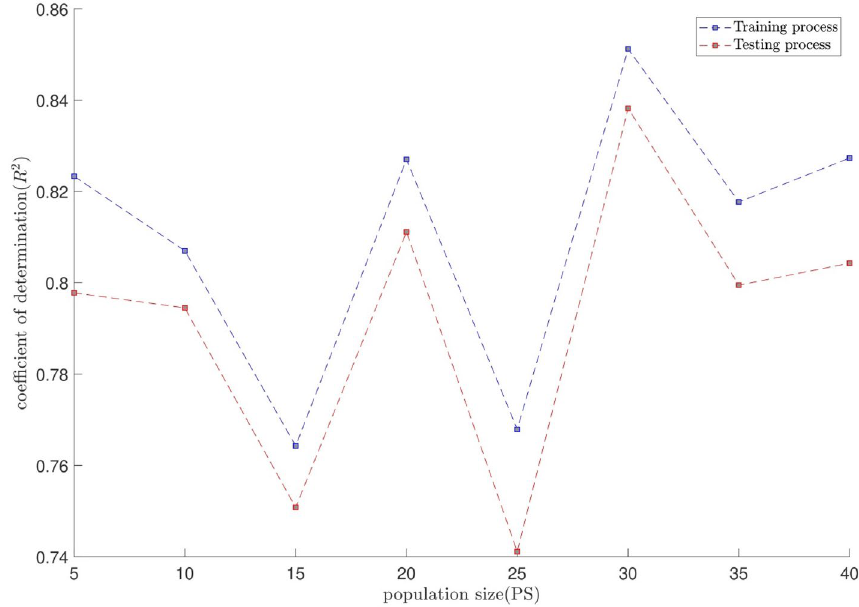
Figure 3. GAFIS method learning processes with changing in population size (P.S).